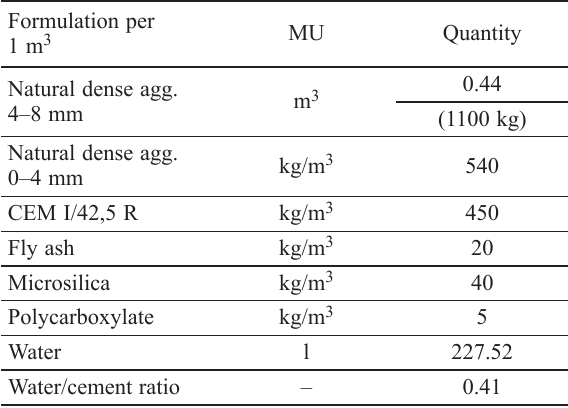
Table 1. Formulation